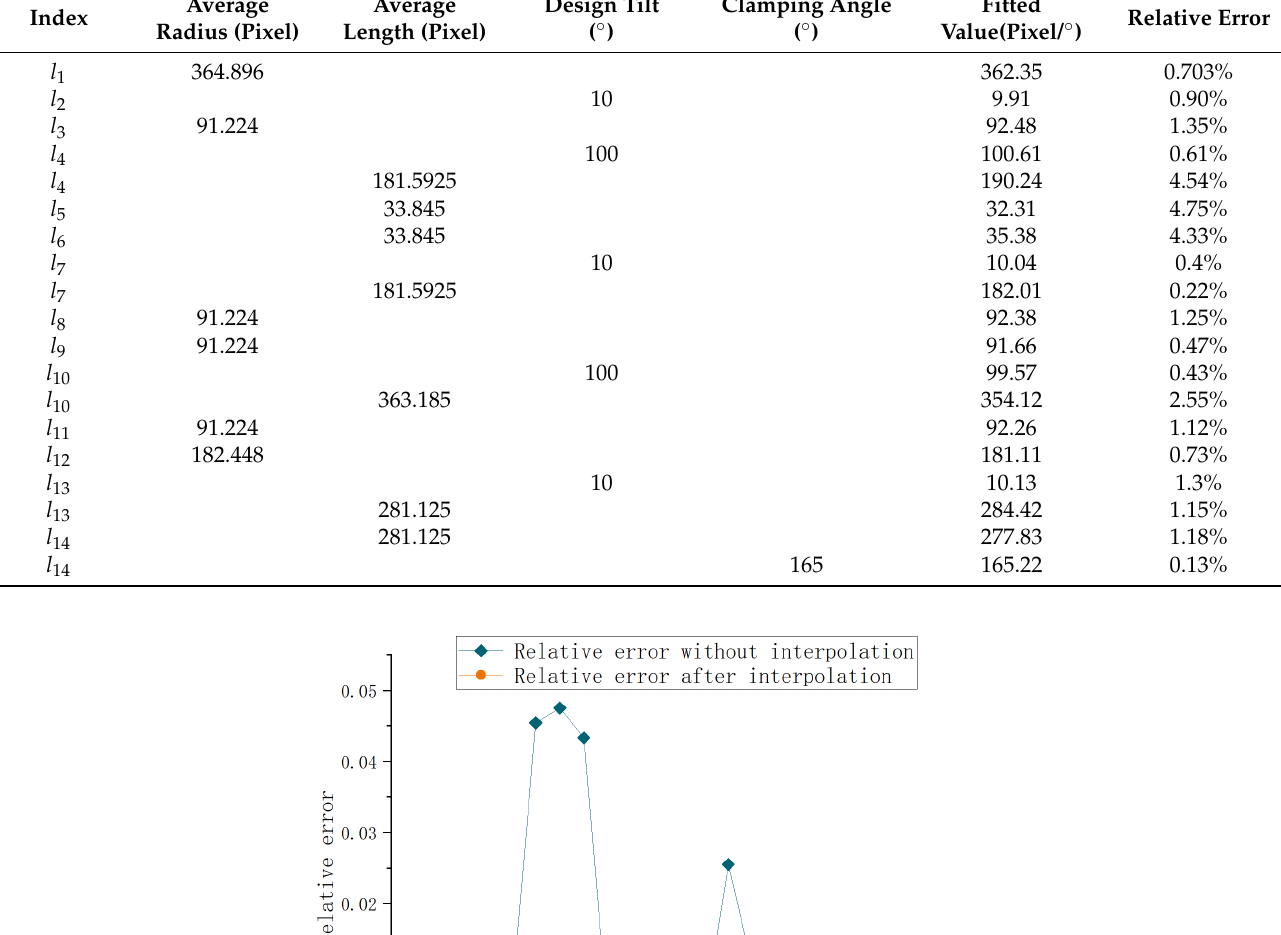
Table 5. Relative errors of fitting results.